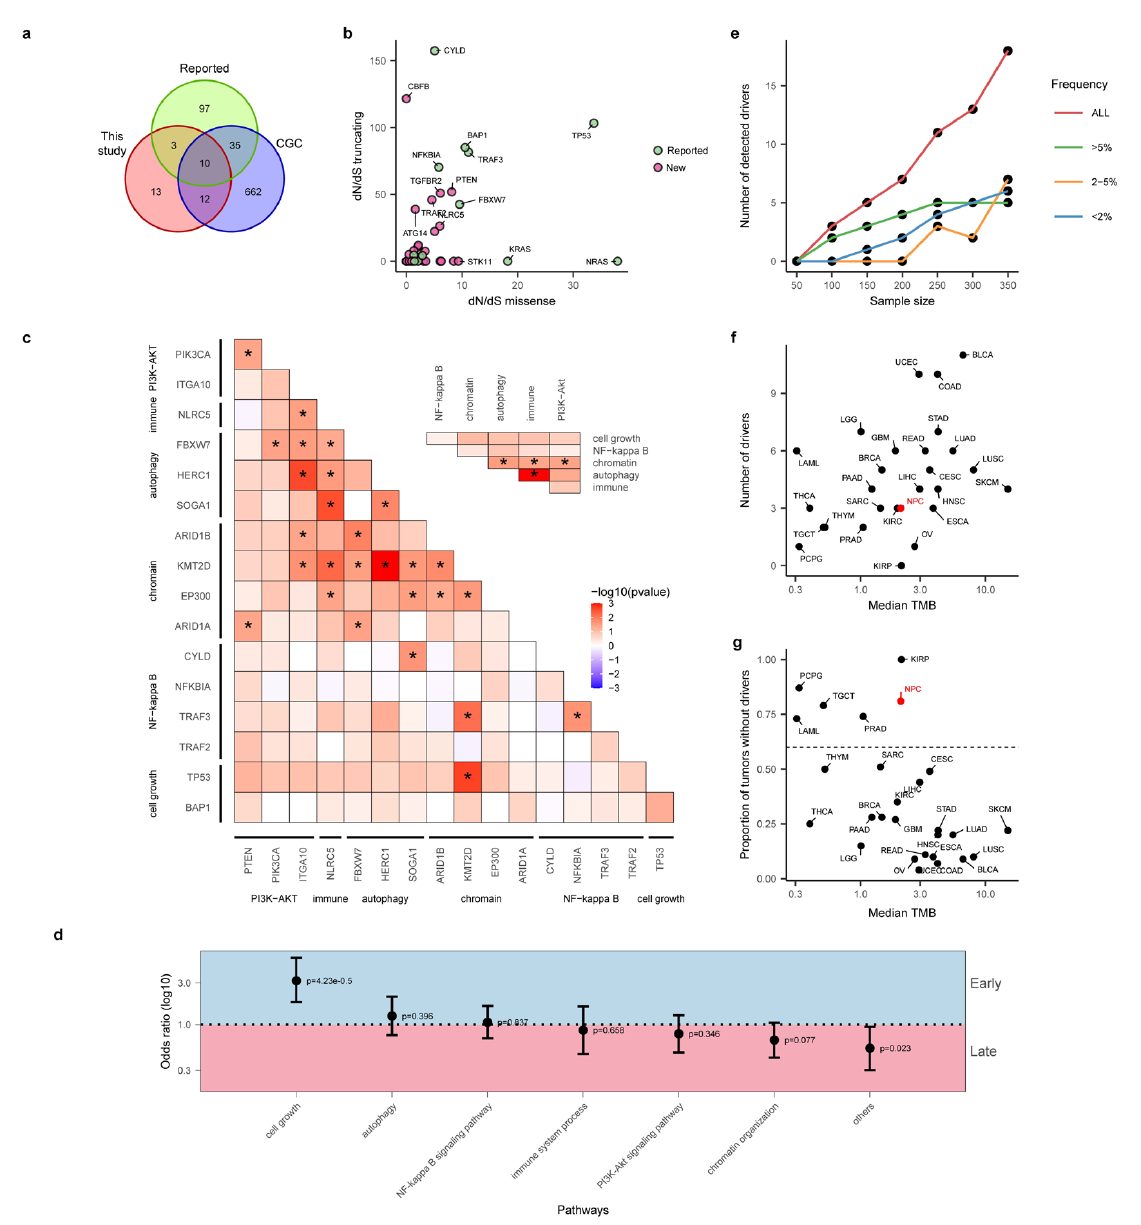
Figure 2. Driver properties and pan cancer comparison. ( a ) Venn diagram between drivers identified in this study (“this study”) from the literature (“reported”) as well as in Cancer Gene Census (CGC). ( b ) d N /d S values based on missense (x-axis) and truncating (y-axis) mutations. Reported drivers are those drivers overlapping between our study and reported driver genes ( a ). ( c ) Correlation between different driver genes (red indicates co-occurrence, blue indicates mutual exclusiveness and * indicates p -value < 0.05); the color corresponds to the strength of the correlation (based on p -value). Inset figure plotted the correlation between drivers at the pathway level. ( d ) Timing of driver mutations in different pathways. Y-axis plotted the odds ratios of early/late mutations in different pathway genes (as compared to the genomic background). ( e ) The relationship between sample size and number of identified driver genes (i.e., saturation plot). ( f ) The relationship between median TMB and number of identified drivers across the TCGA cohort. NPC was labelled as the red dot. Different tumor types from the TCGA were downsampled to the same size of 100 patients for a fair comparison (Methods). ( g ) The relationship between median TMB and the proportion of tumors without driver genes across the TCGA cohort. NPC was labelled as the red dot.